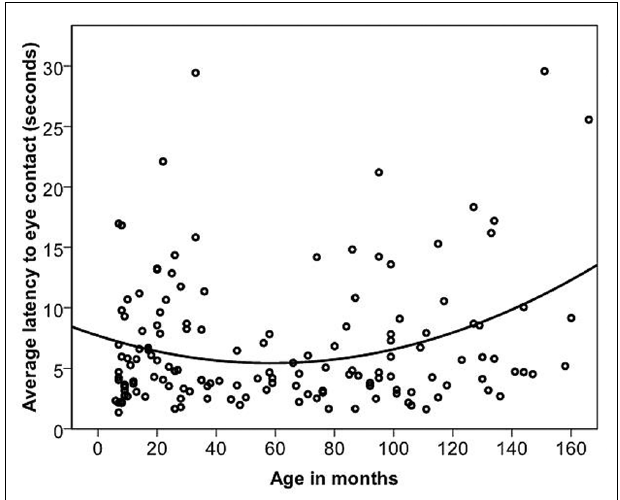
FIGURE 4 |The quadratic relationship between the average latency of the first three trials of individual dogs to gain eye contact with the experimenter and age in months.